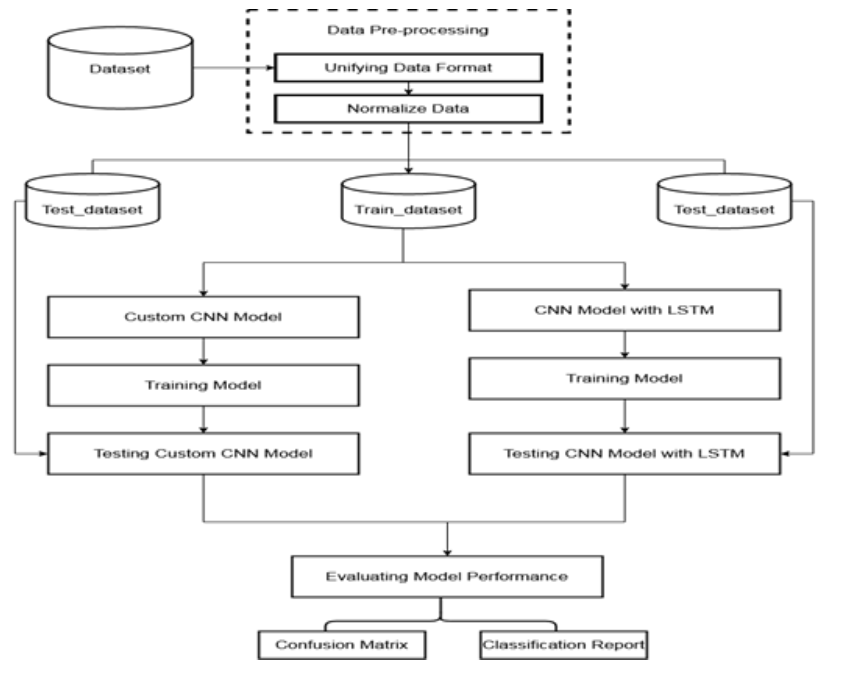
Figure 2. Flow of IDS model.